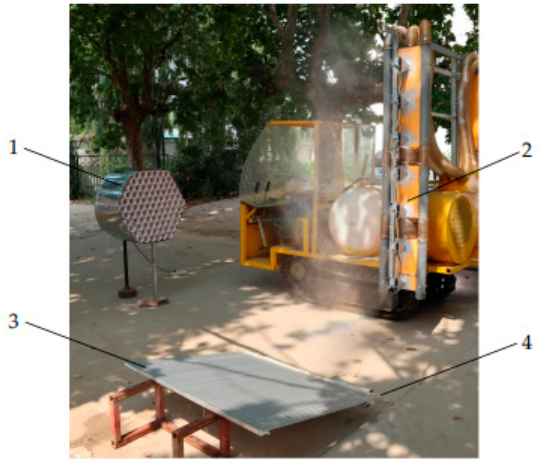
Figure 5. Diagram of the experimental devices: 1. FS-75 industrial fan; 2. Anti-drift spray device in multi-airflow synergy; 3. Droplet collecting plate; 4. Test tube.